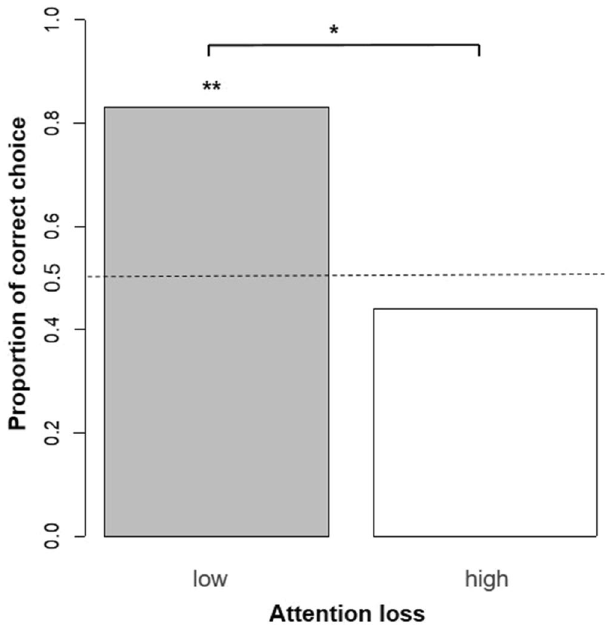
Figure 1. The proportion of correct choices in low and high attention-loss horses. The statistical values indicate the results of the statistical analysis investigating whether the choice was significantly biased compared to a chance level of 0.5 (exact binomial test, n = 18), and investigating whether there were significant differences in the proportion of correct choices of low and high attention-loss horses (Fisher’s exact test, n = 18 for each). **P < 0.01, *P <